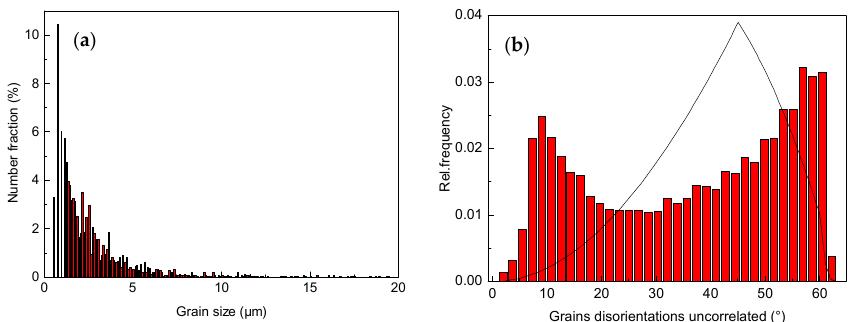
Figure 14. Statistical graph of the welded joint grain size ( a ) and misorientation ( b ). There is no strong oriented texture in the copper base material, mainly brass texture {112}<111>, (<001> ‖ ND) and a cubic texture {001}<100>, (<001> ‖ ND). Figure 15 shows the distribution of the EBSD inverse pole figure (IPF) of the Cu-ETP ultrasonic welding inter- face microstructure and the crystal plane pole figure (PF) of the microstructure at {100}, {101} and {001}. It can be seen that the welds mainly have shear textures {111}<143>, {111}<110> (blue position) and {221}<122> (purple position), and parts of the {001}<130>, {001 }<230> and {114}<131> textures, etc. Among them, there are many regenerated fine cubic textures {100}<001> (red position) and shear textures {111}<110> at the welding in- terface. The evolution of the interface texture is related to the DRV and DRX mechanisms during ultrasonic welding. Figure 15. EBSD maps with the corresponding pole figures: ( a ) IPF, IPFs in zone I ( b ) and II ( c ), ( d ) PFs. The orientation distribution function (ODF) diagram can be used to quantitatively and accurately analyze the spatial distribution of the grain orientation in the texture ma- terial to further characterize the microstructure of the weld (Figure 16). The ODF map was measured to obtain the Euler angle, and the Euler angle was used to calculate the micro- textures in different regions. It can be seen that there are {001} <100> cubic textures, {001} <110> rotating cube textures and {111} <143>, {221} <122> deformation textures in the Cu- ETP welds. This cubic texture is not the cubic texture of the base material but is instead produced during the recrystallization process with ultrasonic welding. The cubic texture